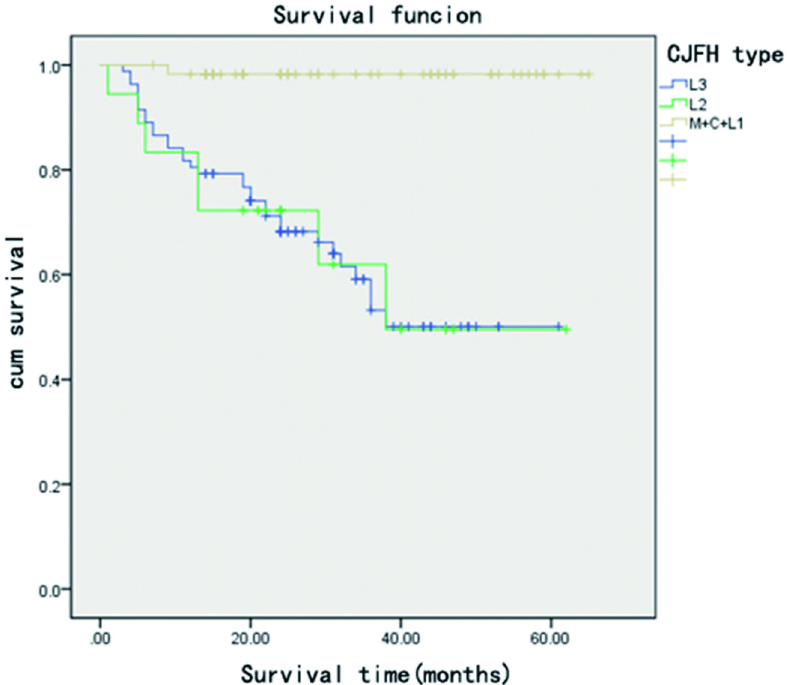
Fig 2. Radiographs of a 46-year-old patient with osteonecrosis of the femoral head of the right side. A) and B) Serial AP and frog lateral radiographs showing ONFH ARCO stage IIIa/CJFH type L2 on the right sides. Subchondral insufficiency fracture can be clearly observed on the frog lateral radiographs. C) and D) Preoperative magnetic resonance image shows that the necrotic lesions involve the lateral pillar. E) and F) Serial AP and frog lateral radiographs taken eight months post operation show a progressive collapse of the femoral